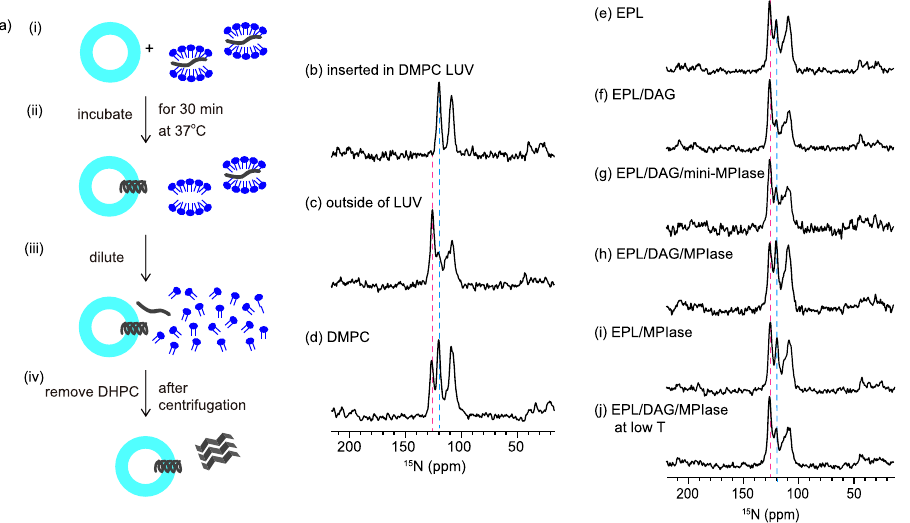
Figure 3. ( a ) Procedure for inserting Pf3_24_3 (Fig. 1d) into membranes. (i) Pf3_24_3 (dark gray) solubilized in a DHPC solution was mixed with LUVs composed of various types of lipids. (ii) The mixture was incubated for 30 min at 37 °C. (iii) Then, it was diluted with a buffer solution until the concentration of DHPC reached below the critical micelle concentration of DHPC (1.6 mM). (iv) The supernatant containing DHPC was removed after centrifugation and this step was repeated two times to remove DHPC. We confirmed that Pf3_24_3 outside the membrane was completely precipitated at this stage and not present in the supernatant (Fig. S5). The precipitates were subjected to 15 N CPMAS NMR. ( b – j ) 15 N CPMAS NMR spectra of Pf3_24_3. ( b ) Pf3_24_3 reconstituted into DMPC LUV. The membrane insertion procedure shown in ( a ) was omitted for this sample. ( c ) Pf3_24_3 in the aggregates. The sample was prepared as shown in ( a ) but without using LUVs. Therefore, all proteins were recovered as aggregates. ( d – j ) The sample was prepared as shown in ( a ). The LUVs were composed of DMPC ( d ), EPL ( e ), EPL/5 mol% DAG ( f ), EPL/5 mol% DAG/5 mol% mini-MPIase-3 ( g ), and EPL/5 mol% DAG/1 mol% MPIase ( h ), EPL/1 mol% MPIase ( i ). ( j ) The lipid composition was similar to ( h ), but all membrane insertion processes were performed below 4 °C. The pink and light blue dashed lines show the chemical shift at 125.6 and 119.6 ppm, respectively.